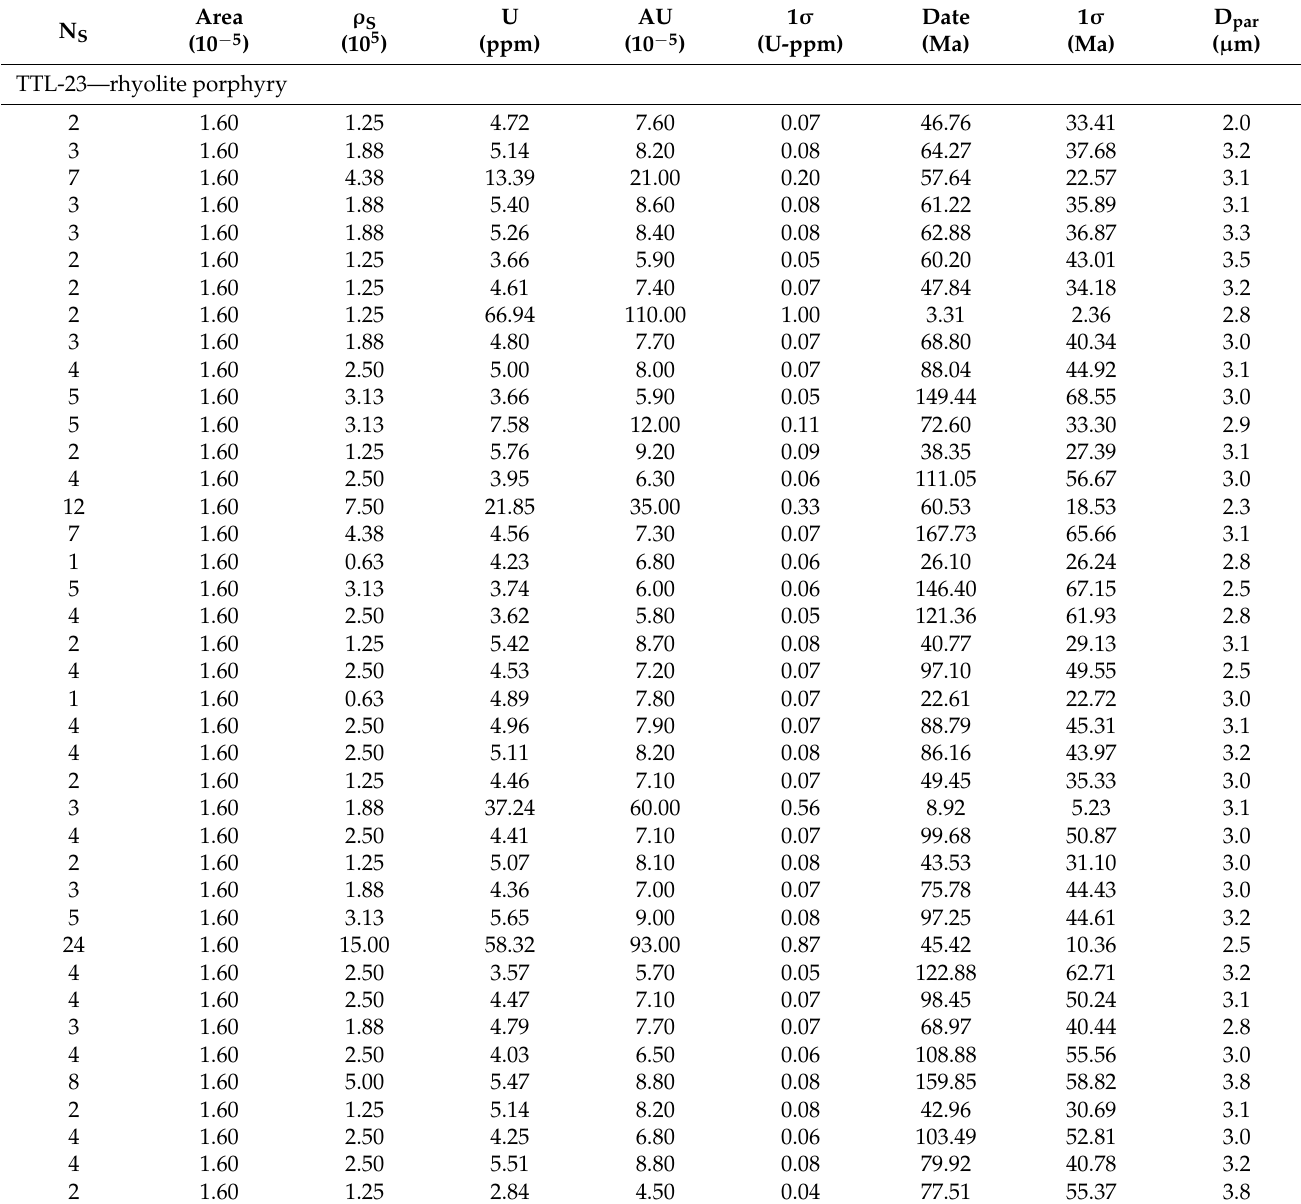
Table A2. Fission-track results analysed in this